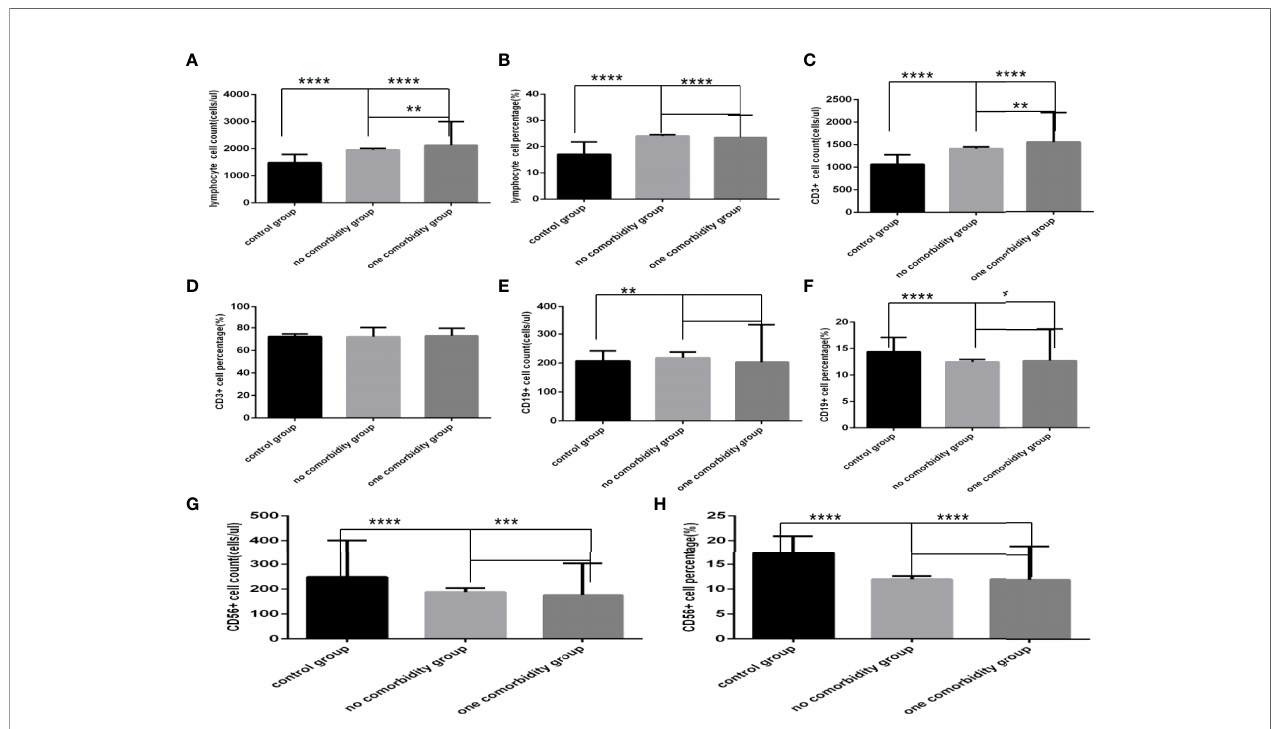
FIGURE 4 | Comparison of lymphocyte, T, B and NK cell subset counts and percentages among the control group, the no comorbidity group and the one comorbidity group ( n =494; control, no, one comorbidity groups, n =55, 246 and 193 cases, respectively). COVID-19, coronavirus disease 2019. NAFLD, nonalcoholic fatty liver disease. DM, diabetes mellitus. CHB, chronic hepatitis (B) COPD, chronic obstructive pulmonary disease. CKD, chronic kidney disease. CVD, cardiovascular disease. (A) lymphocyte count. (B) lymphocyte percentage. (C) CD3+ count. (D) CD3+ percentage. (E) CD19+ count. (F) CD19+ percentage. (G) CD56+ count. (H) CD56+ percentage. One-way ANOVA was used for intergroup comparisons ( A, B, C, G, H , P all<0.0001; F, P <0.01; D, E , P all>0.05). Unpaired t -tests were used for comparisons with the control group, and with the no comorbidity group, * P < 0.05, ** P < 0.01, *** P < 0.001, **** P < 0.0001.